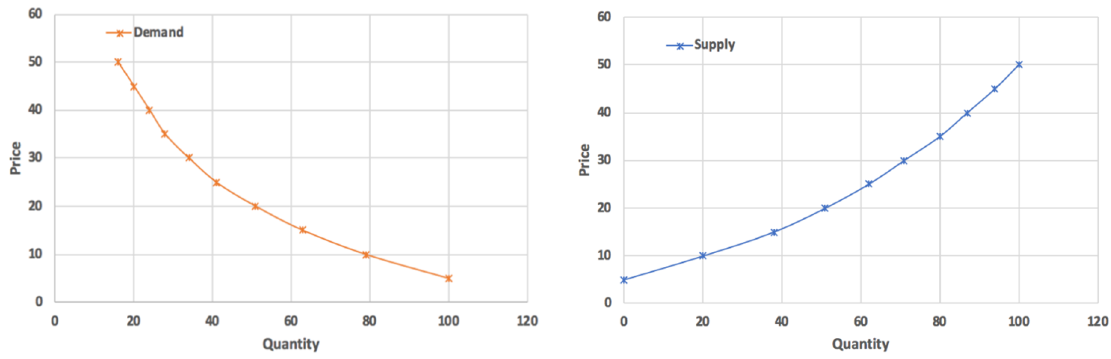
Figure 1. Demand and supply curves.